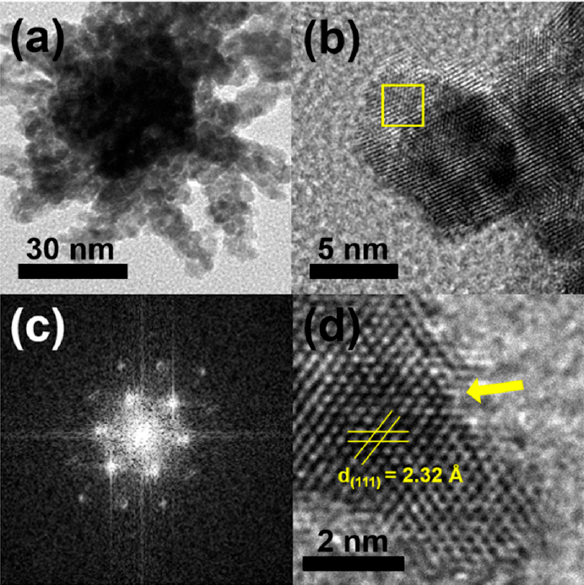
Figure 3. TEM images of; ( a ) an Au–Pt HP-UNC; and ( b ) branch of an Au–Pt HP-UNC. ( c ) FFT pattern obtained from yellow square in ( b ). ( d ) HR-TEM image in the branch of an Au–Pt HP-UNC.